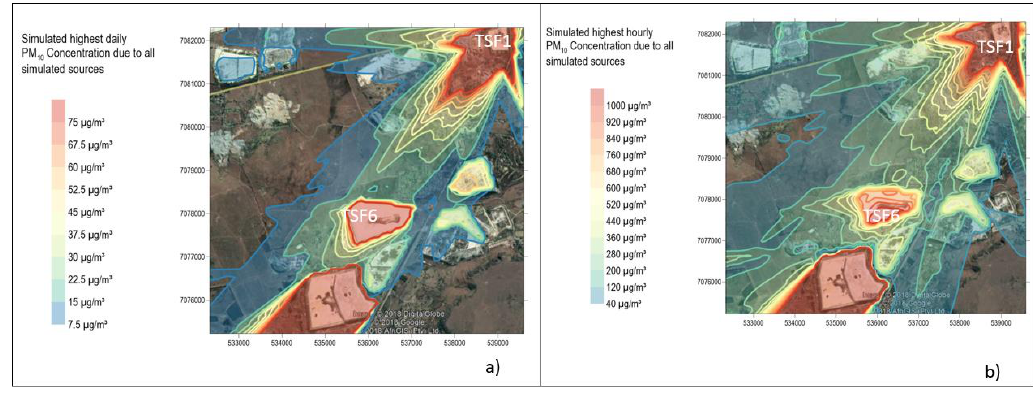
Figure 7. Simulated highest daily PM10 ( a ) and highest hourly PM10 ( b ) concentration due to all simulated sources.